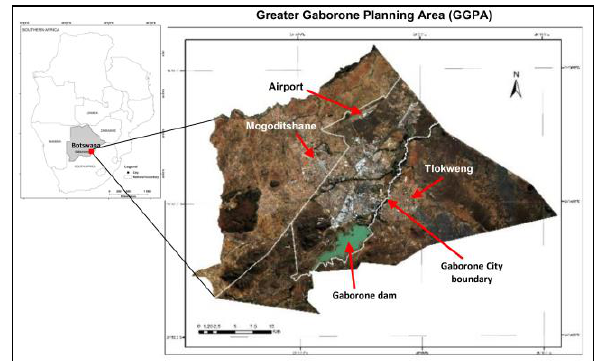
Figure 1 . Location of study area and RGB image of the Greater Gaborone Planning Area (GGPA) in Botswana.